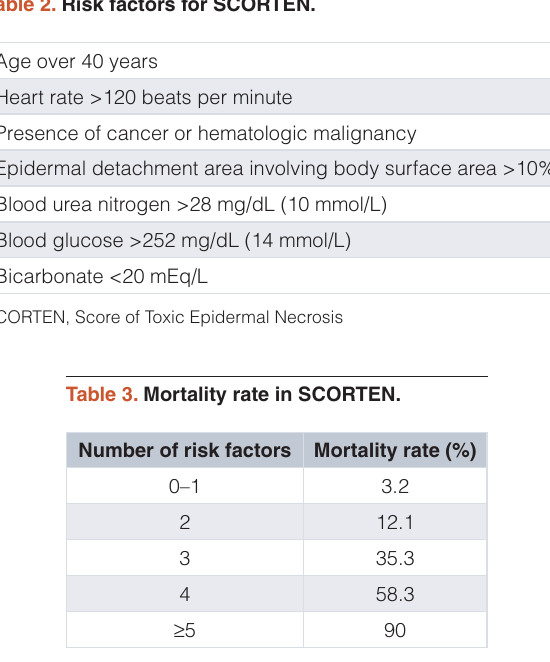
Table 2. Risk factors for SCORTEN.